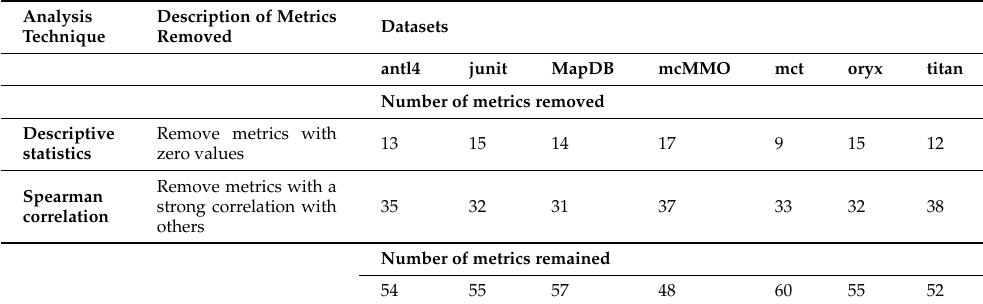
Table 7. Number of metrics removed in each data analysis